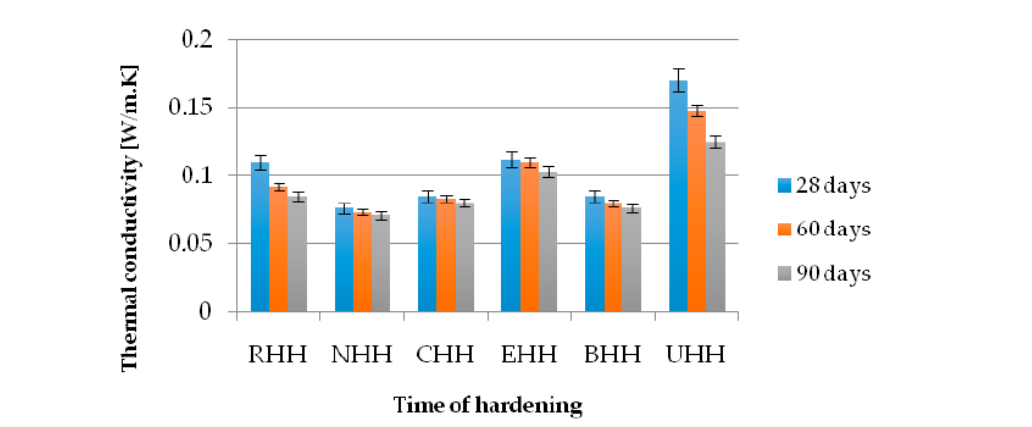
Figure 3. The thermal conductivity coefficient values of the original and treated hemp composites after 28, 60, and 90 days of hardening.